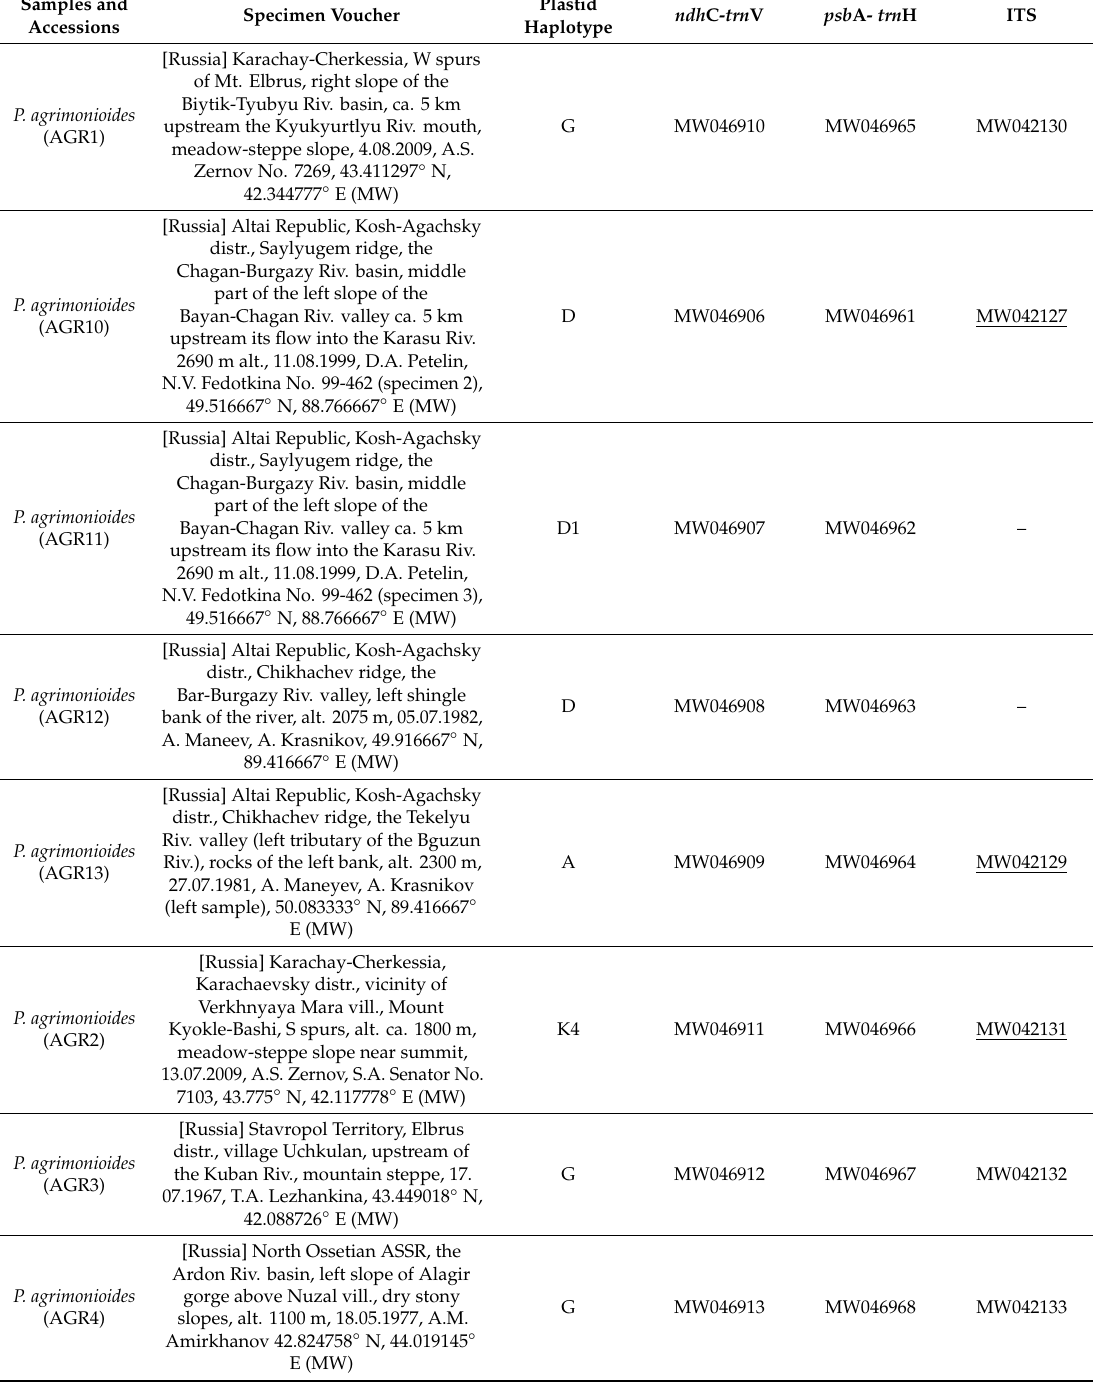
Table A1. Species, accessions, specimen vouchers, plastid haplotypes, and GenBank accession numbers of plastid and nuclear ITS sequences used in the study. Underlined ITS accession numbers indicate the presence of ambiguous positions in ITS sequences (putative